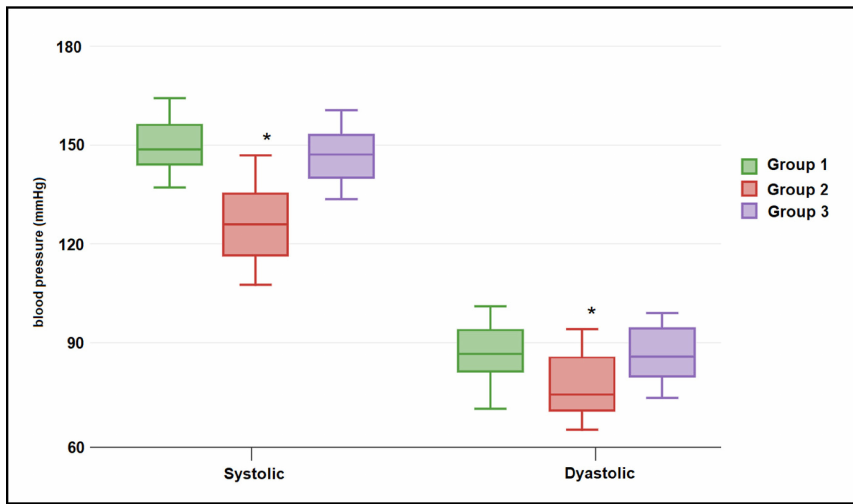
Figure 1. Systolic and diastolic blood pressure levels at initial measurement, stratified by study groups. Data presented as median (IQR) and analyzed using the Kruskal–Wallis test. * Dunn’s post-test analysis (significant at α <